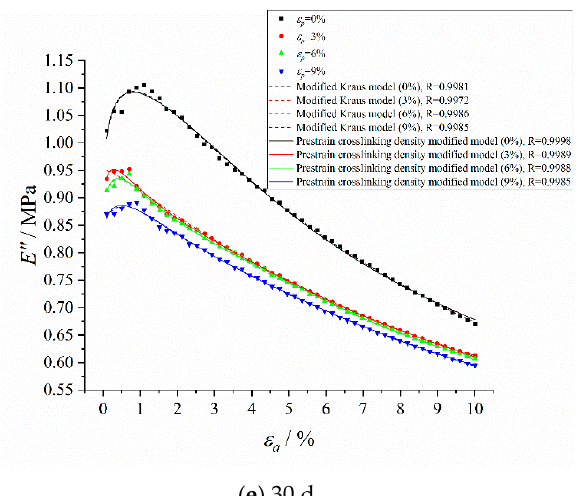
Figure 15. The loss modulus fitting curves of the pre-strain crosslinking density modified model and modified Kraus model under pre-strain. ( a ) Aged for 0 d; ( b ) Aged for 6 d; ( c ) Aged for 12 d; ( d ) Aged for 20 d; ( e ) Aged for 30 d.